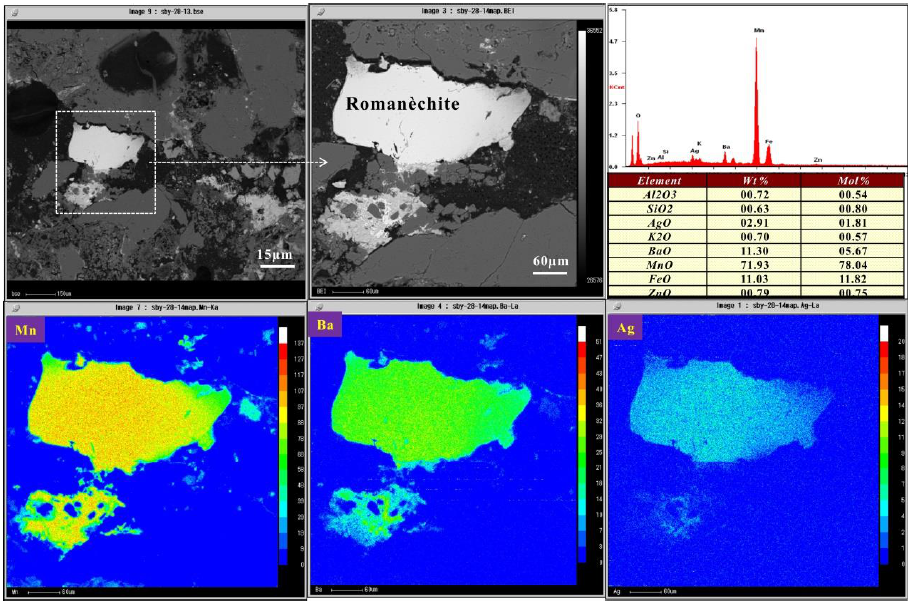
Figure 11 Figure 11. BSE images and element distribution of roman è chite from the Sanbao